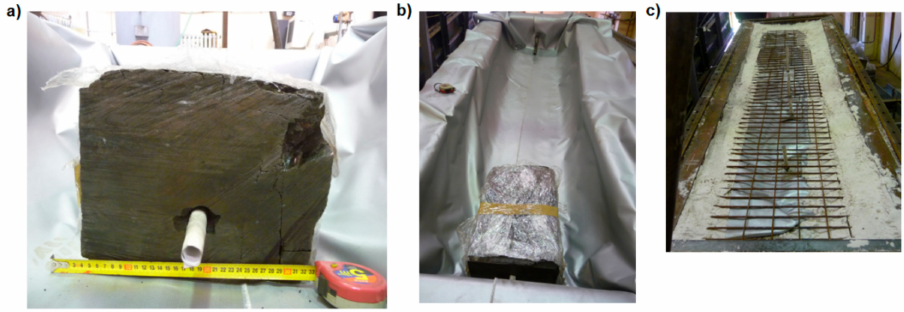
Figure 4. The construction of the coal model ( a ) gasification channel placement, ( b ) thermal insulation of coal blocks, ( c ) reinforcement of coal model top part (Source: own